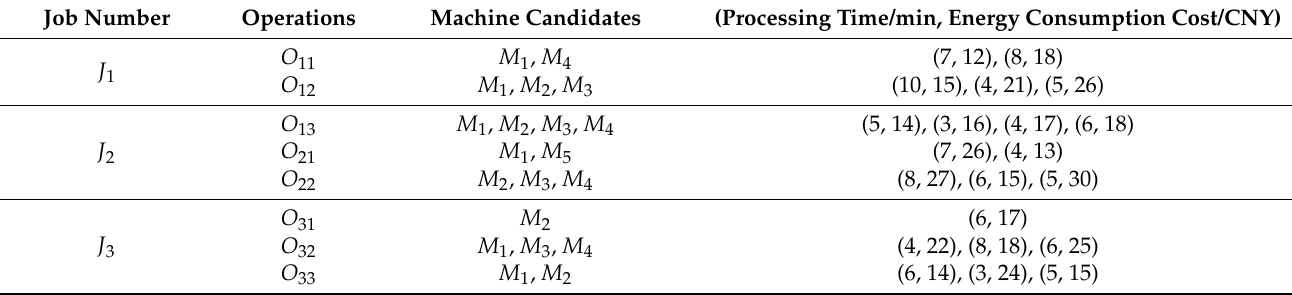
Table 1. One numerical instance of the EFJSP.